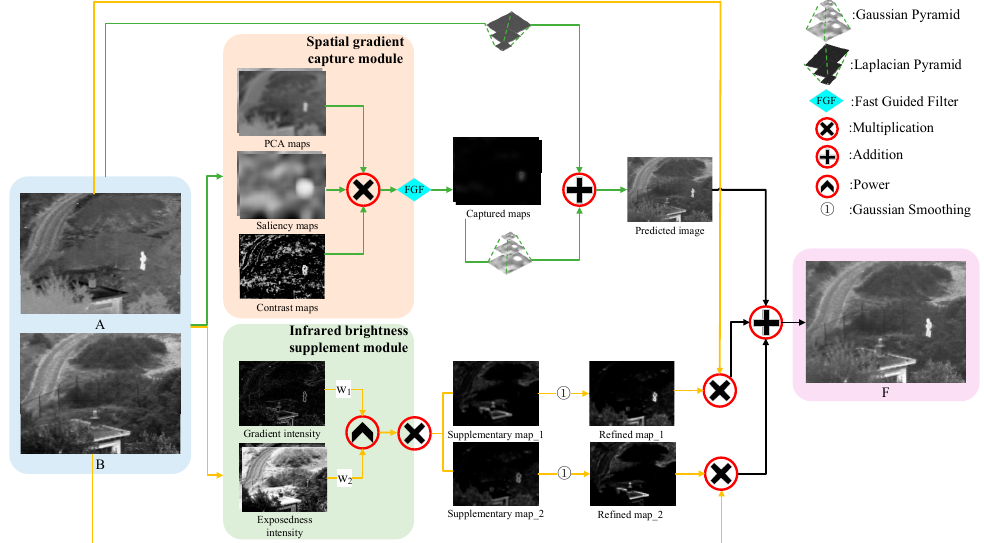
Figure 1. Flowchart of the IVIF method via feature-oriented dual-module complementary. Different line formats represent different sections. A, B, and F represent the infrared image, visible image, and fused image, respectively.